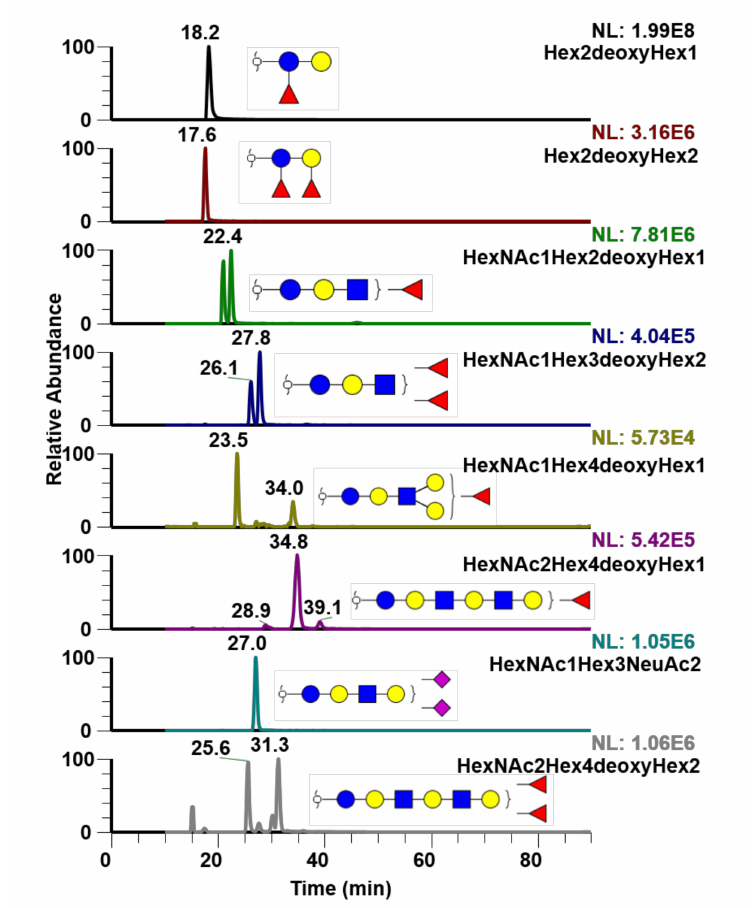
Figure 6. EIC (Extracted ion chromatogram) of free oligosaccharides extracted from human milk. Isomeric separation of some free oligosaccharides was achieved using PGC-LC-MS. MS2 spectra of the displayed structures were depicted in Figures